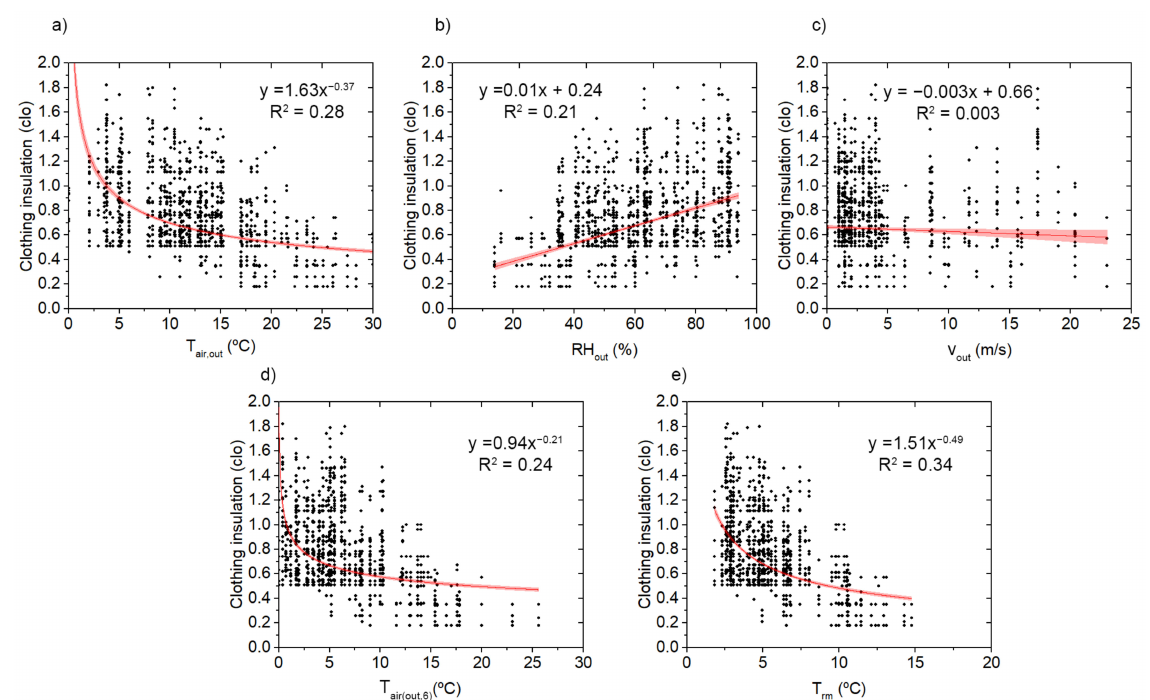
Figure 4. Relationship between outdoor environmental factors and clothing insulation: ( a ) outdoor air temperature; ( b ) outdoor air RH; ( c ) outdoor air velocity; ( d ) outdoor air temperature measured at 6:00 a.m.; ( e ) outdoor running mean temperature. The red line indicates the curve fit (95% confidence interval).